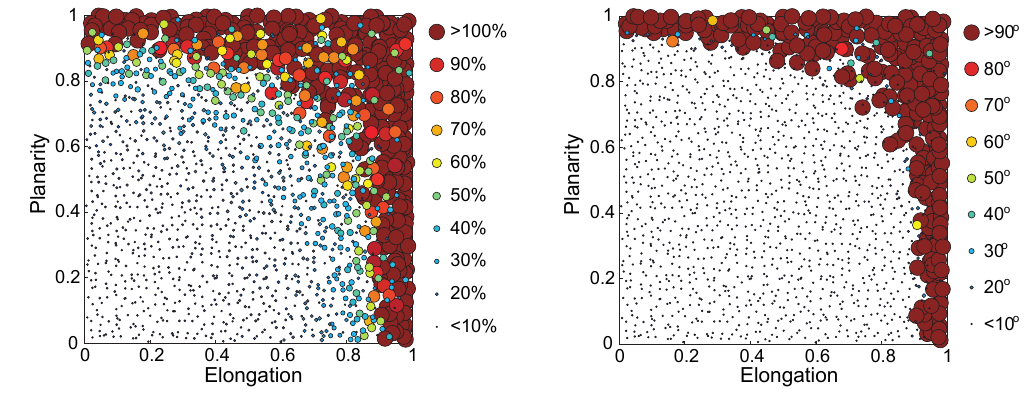
Fig. 4. Same format as in Fig. 2, but only those cases with all of the four residuals smaller than 1s are selected in the simulation.